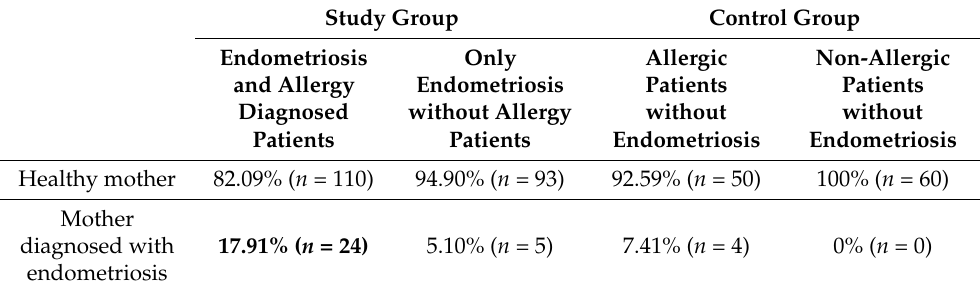
Table 3. Characteristics of the medical